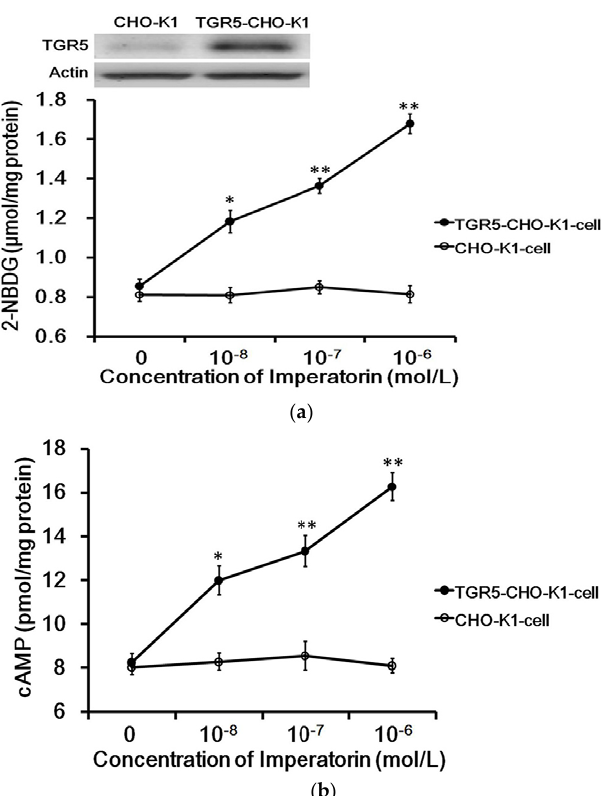
Figure 1. Role of TGR5 activation in imperatorin-induced glucose uptake in cells. ( a ) Successful transfection of CHO-K1 cells with the TGR5 gene was confirmed via Western blotting analysis. Dose-dependent changes in glucose uptake induced by imperatorin in TGR5-transfected CHO-K1 cells (TGR5-CHO-K1 cells) compared with cells transfected with an empty vector (CHO-K1 cells). ( b ) Glucose uptake was measured as described in the Materials and Methods section. Dose-dependent increases in cAMP levels induced by imperatorin in TGR5-transfected CHO-K1 cells (TGR5-CHO-K1 cells) compared with cells transfected with an empty vector (CHO-K1 cells). The cAMP levels were measured with ELISA kits as described in the Materials and Methods section. Values (mean ± SEM) were obtained from eight measurements in each group. * p < 0.05, ** p < 0.01 and *** p < 0.001 compared with the vehicle-treated group (0 mol/L). Nutrients 2017 , 9 , 1192